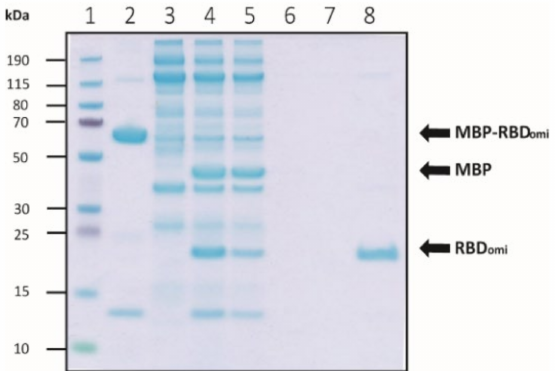
Figure 4. Purification of the soluble MBP-cleaved RBD omi . Purification and cleavage efficiency were analyzed by bis-tris SDS-PAGE. The lanes of SDS-PAGE are as follows: lane 1, protein size marker (Thermo); lane 2, purified MBP-RBD omi ; lane 3, 50 units of thrombin; lane 4, thrombin digested MBP-RBD omi ; lane 5, Ni-NTA flow through fraction; lane 6, Ni-NTA first wash fraction; lane 7, Ni-NTA second wash fraction; lane 8, Ni-NTA elution fraction.